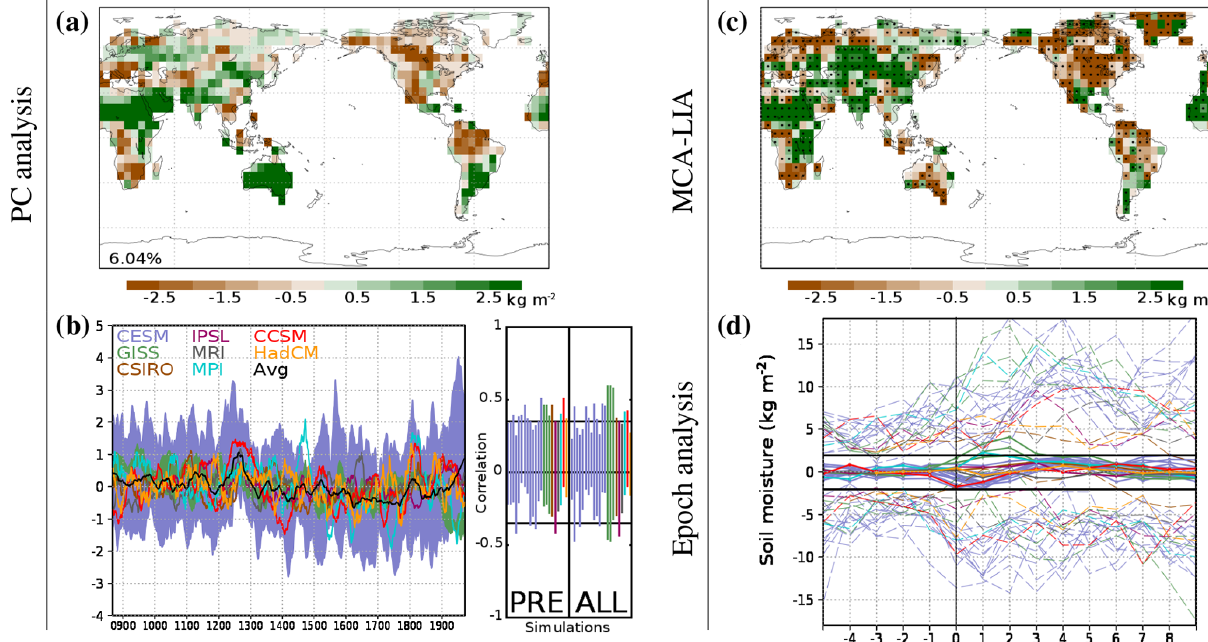
Figure 17. Analysis of soil moisture for the ensemble of simulations included in Table 1. (a) Second EOF and (b) second PC time series for each simulation, as well as the average PC of all the simulations (black line). The percentage of explained variance is shown within the EOF map. The range of correlations between the PC of each simulation and those of other simulations is also included on the right of the plotted PCs both for the whole period (ALL) and for the preindustrial era (PRE). For these correlations, the significance level ( p < 0 . 05) accounting for autocorrelation is shown with a black line. (c) Map of soil moisture differences between MCA and LIA. Dots indicate locations where the differences are significant ( p < 0 . 05). (d) Composite average (solid lines) and maximum and minimum (dashed lines) global soil moisture anomalies in the 5 years before and 10 years after the 12 main volcanic eruptions of the LM. The vertical line indicates the year of the volcanic event. The horizontal black lines show the significance level of the average ( p < 0 . 10) based on the distribution of averages of 12 years generated with 2200 sets randomly taken from the whole period excluding the years of the 12 main volcanic eruptions and the 10 years after